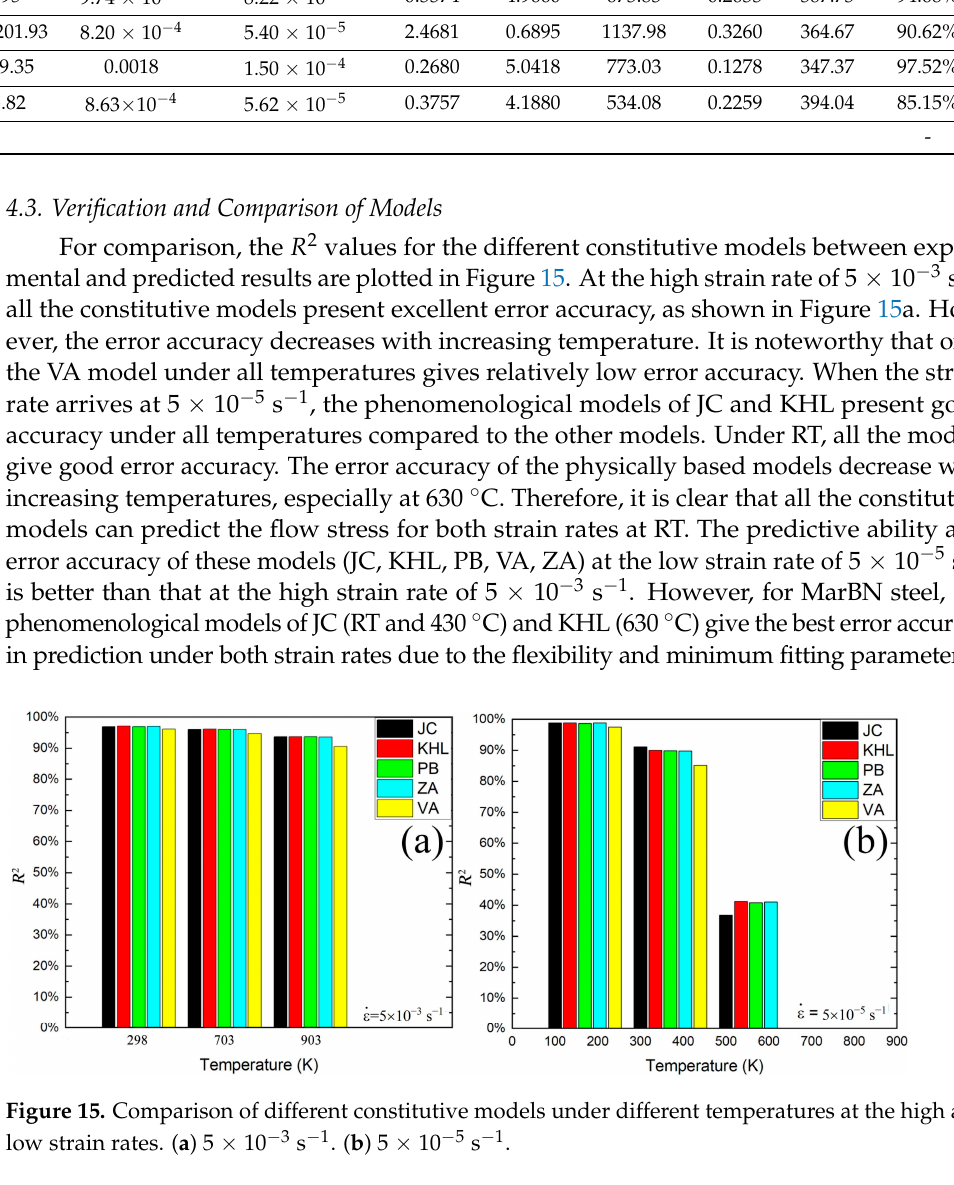
Figure 16. The predicted true stress–true plastic strain curves based on the JC and KHL models and experimental results at the strain rates of ( a ) 5 × 10 − 3 s − 1 and ( b ) 5 × 10 − 5 s − 1 . 5. Conclusions In the current paper, the thermomechanical behavior, microstructure, and constitu- tive models for MarBN steel are investigated at the strain rates of 5 × 10 − 3 s − 1 and 5 × 10 − 5 s − 1 under temperatures ranging from RT to 630 °C. Several conclusions can be obtained as follows, 1. Serrated flows are observed under all temperatures at the high strain rate of 5 × 10 − 3 s − 1 (type C serrations) and under 430 and 630 °C at the low strain rate of 5 × 10 − 5 s − 1 (type A+B serrations). This behavior is related to the strain rate and temperature for MarBN steel.